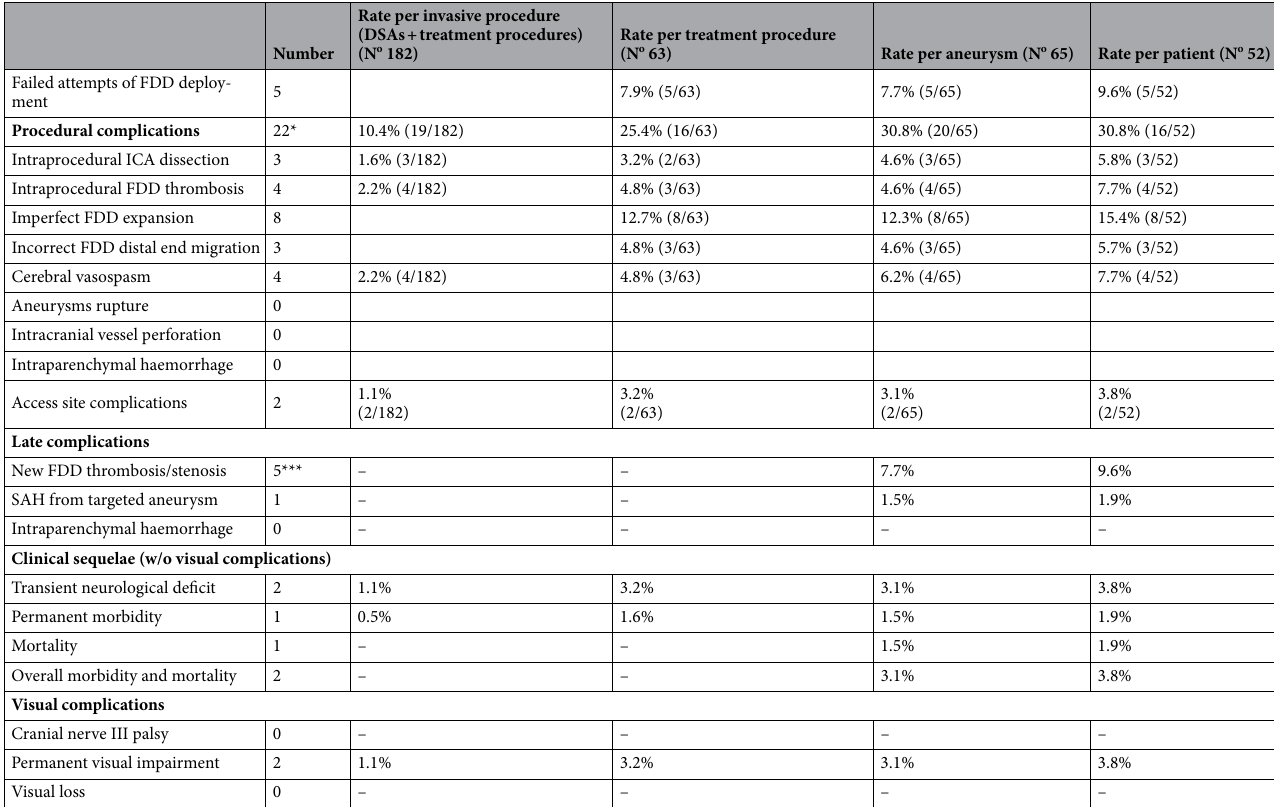
Table 3. Summary of complications. *Total number of adverse events of all DSAs and treatment procedures. **55 ICAs were covered with FDDs, i.e. bilaterally in 3 cases. ***One late FDD thrombosis, that occurred during the follow-up DSA procedure, was also incorporated in “procedural